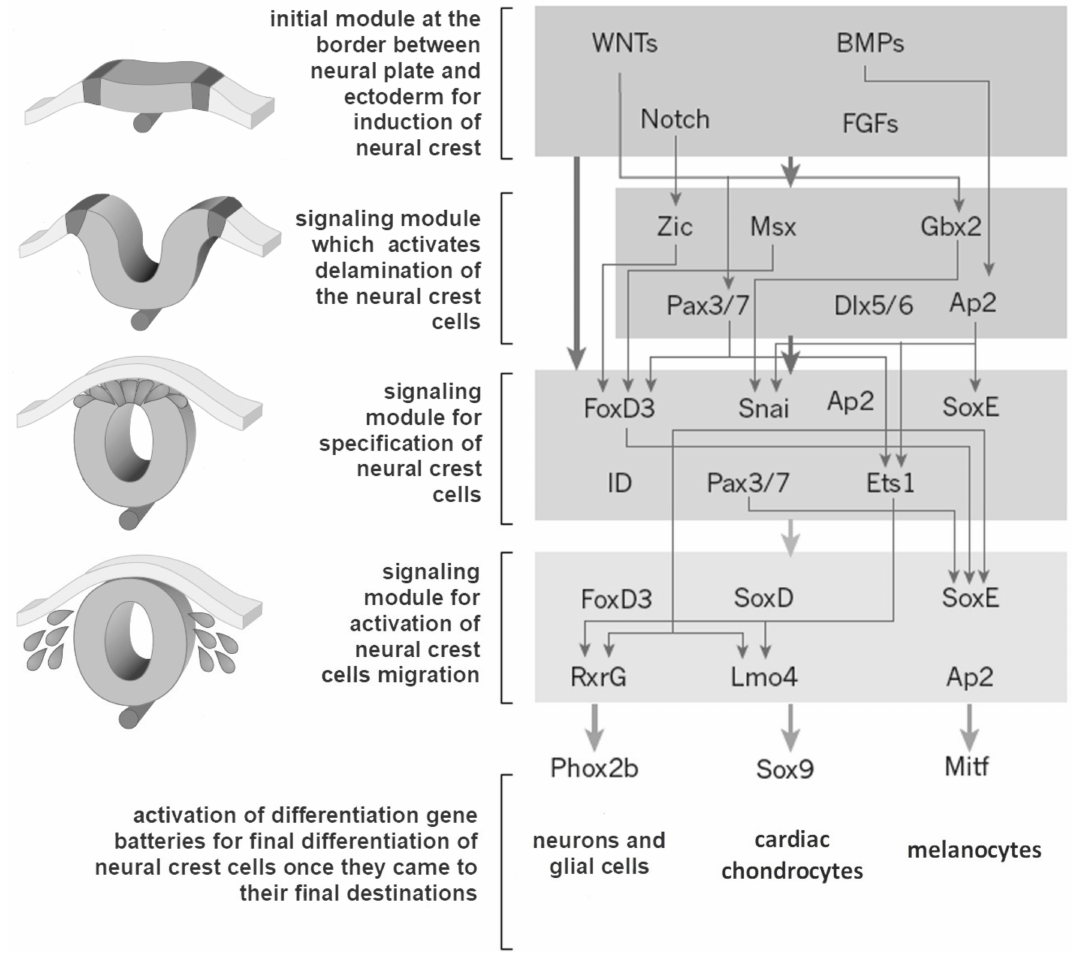
Figure 4. Simplified schematics of stepwise activation of the regulatory gene modules and networks for NCCs development, delamination, specification, migration, proliferation, and differentiation. Genes for specification of the first signaling module, which induces neural crest, do not exist in invertebrates. Scheme is modified according to Green et al. (2015) [39] and Sim õ es-Costa et al. (2015) [35]. Today, it is known that the specification and migration modules include more genes, including Twist , Sox5 , Sox9 , Myc , Tfap2 , Sox10 , Myb , RxrG , Myc , and many